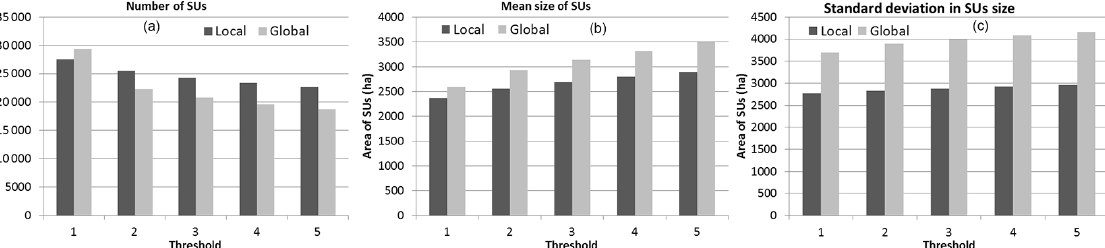
Figure 7. Sensitivity of the global (gray) and local (black) methods to different values of area threshold for the total number of SUs (a) , average SUs size (b) and standard deviation in SU size (c) of the elevation-based geo-located SUs derived using different values of area threshold.